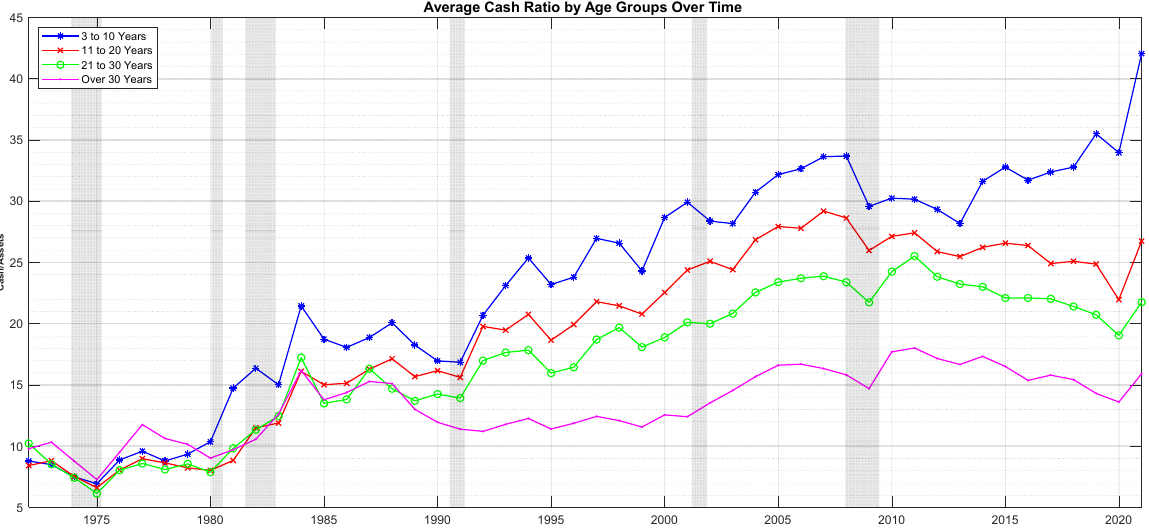
Figure 3. Average cash holdings ratio by age group. Figure 3 plots the cross-sectional average cash and short-term investments to total assets ratios by age group. We consider a firm’s age 1 when it appears in the yearly Compustat data the first time, 2 in the subsequent year, and so on. We divide sample firms into four groups according to their age (three to ten years, eleven to twenty years, twenty-one to thirty years, and more than thirty years), compute their cross-sectional average cash ratio for each year, and plot these ratios over time. The solid lines with *, x, o, and . marks represent cross-sectional average cash and short-term investments to total assets ratios for firms with 3 to 10, 11 to 20, 21 to 30, and over 30 years of age, respectively.